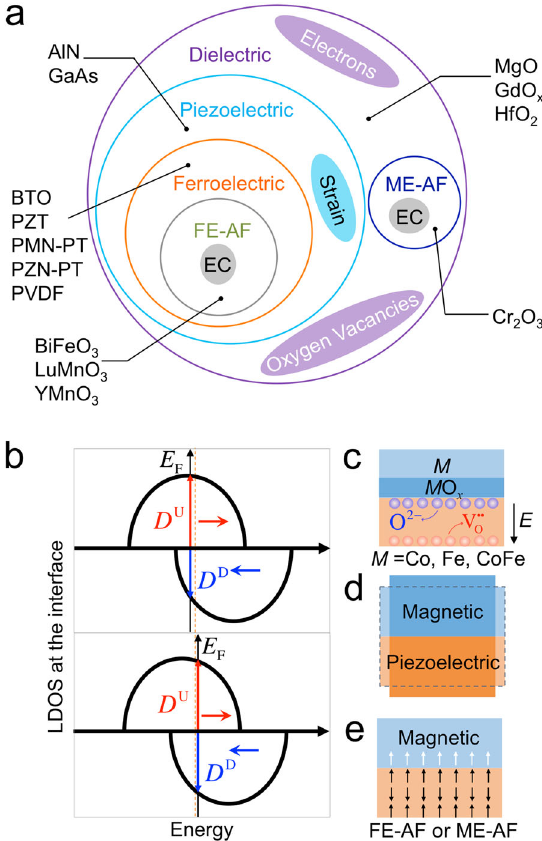
Fig. 2 a Classifying magnetoelectric (magnetic/dielectric) hetero- structures by the functionality of the dielectric materials, along with the representative dielectric materials. The solid ellipses suggest the corresponding mechanisms of converse magnetoelectric coupling. Schematics explaining the mechanisms of converse magnetoelectric coupling enabled through electric fi eld modulation of b spin- polarized electron densities, c degree of interfacial oxidation, d strain, and e exchange coupling. In b the change of electron densities shifts the Fermi level E F and hence the LDOS. In c the details of how the interfacial oxide ( M O x ) layer affects the magnetic anisotropy of the overlaying metal M remain unclear (see the section of Remaining questions). In e only one single AF domain with perpendicular sublattice magnetizations (see arrows in the bottom layer) is shown for simplicity. The exchange coupling arises from the Heisenberg-type exchange interaction between the uncompensated surface magnetization (canted magnetization in BiFeO 3 ) and the local magnetization at the bottom of the magnet. Note that the converse magnetoelectric coupling illustrated in c involves the exchange of both matter and energy across the interface (that is, through an interfacial redox reaction), whereas the coupling illustrated in a , b , d , and e only involve the exchange of (magnetic, elastic, electric) energy. FE-AF Ferroelectric-antiferromagnetic, ME-AF